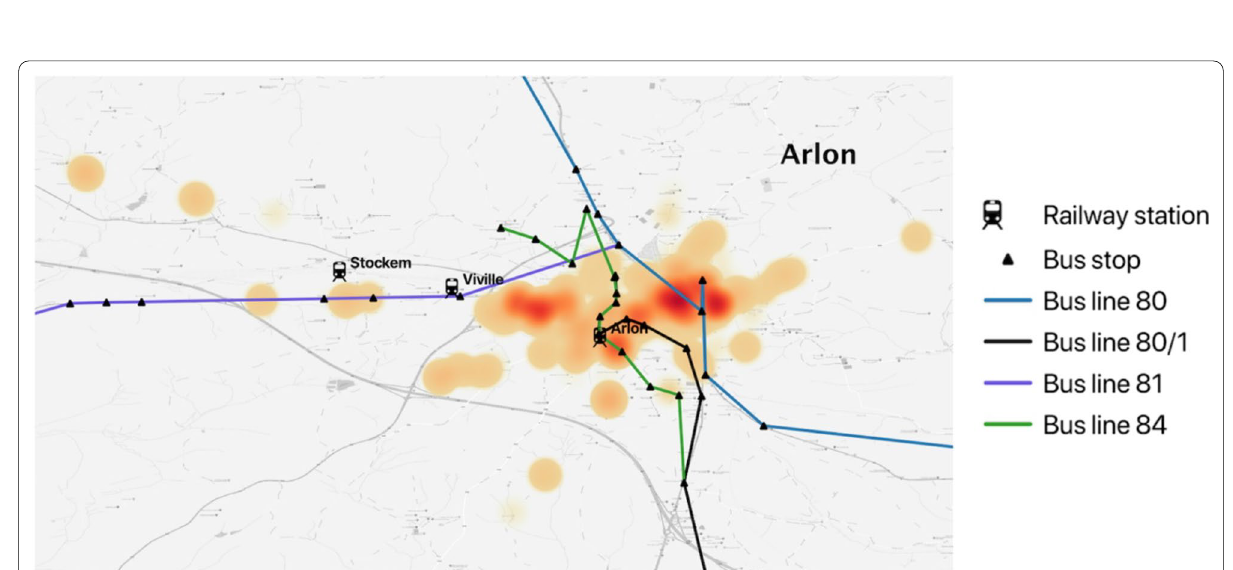
Fig. 4 Available cross‑border bus lines for Kussbus users in the Arlon region (the hot spots are Kussbus ride request